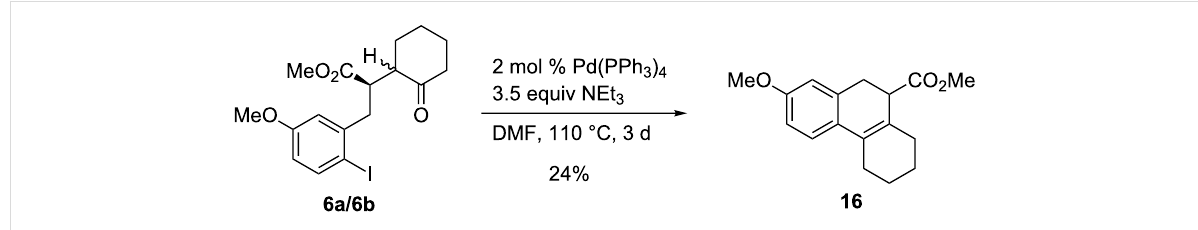
Scheme 7: Palladium-catalyzed cyclization of p -methoxy-substituted aryl iodide 6a / 6b to compound 16 .